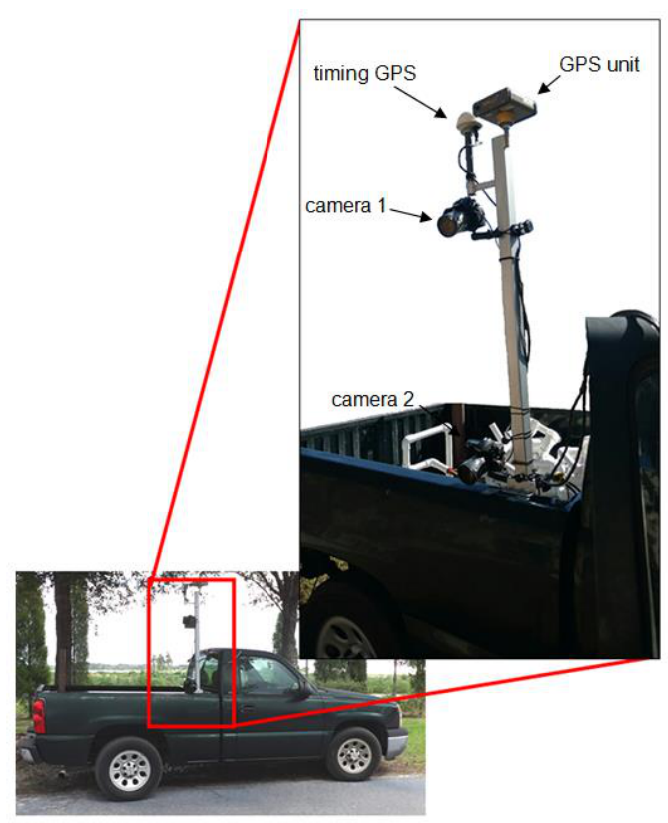
Figure 2. Mounted vehicle set-up used for mobile photogrammetry in this study.